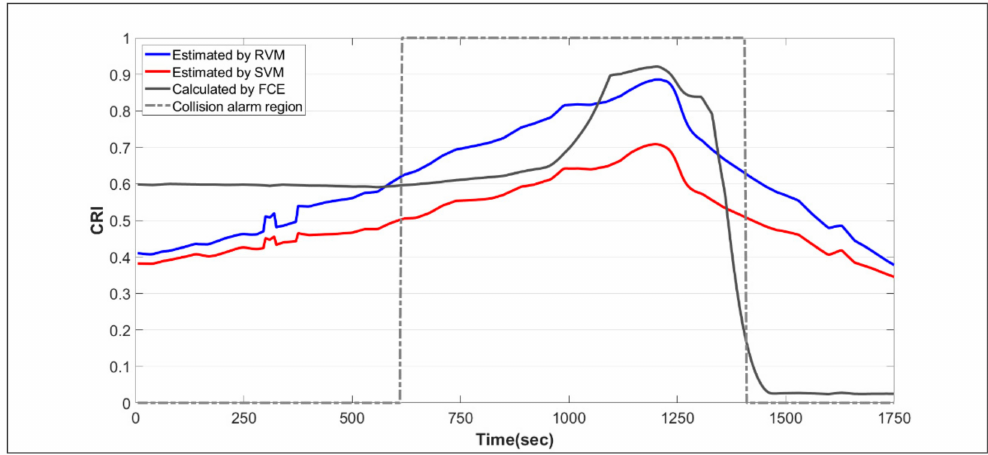
Figure 7. Results of estimation in the case of head-on